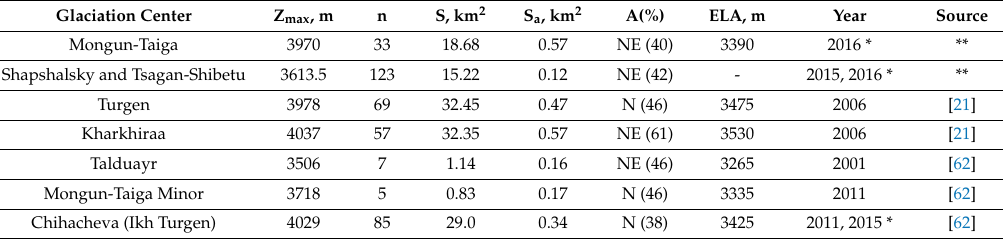
Table 2. General information abour the glaciations of the research